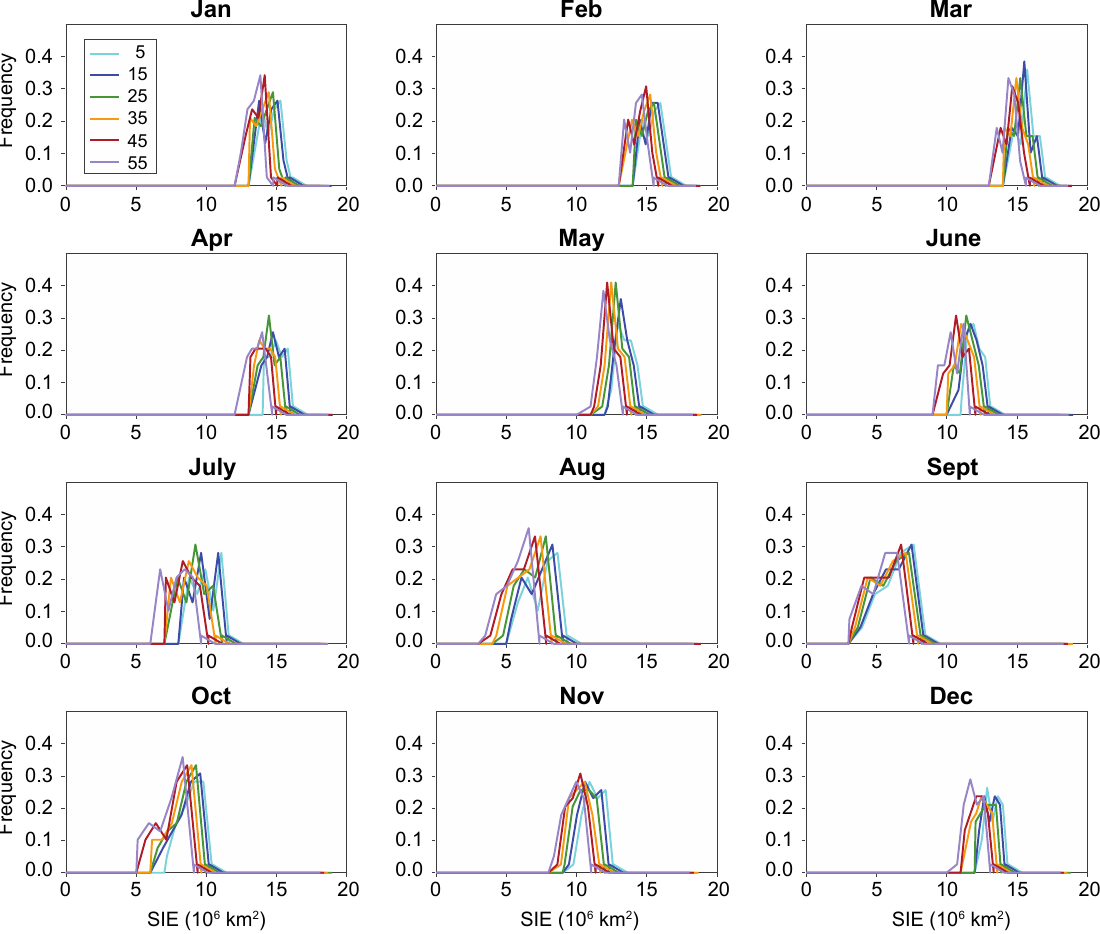
Figure 3. Histograms of SIE over the 1979–2017 time period by month for different concentration thresholds (colored lines, in %).